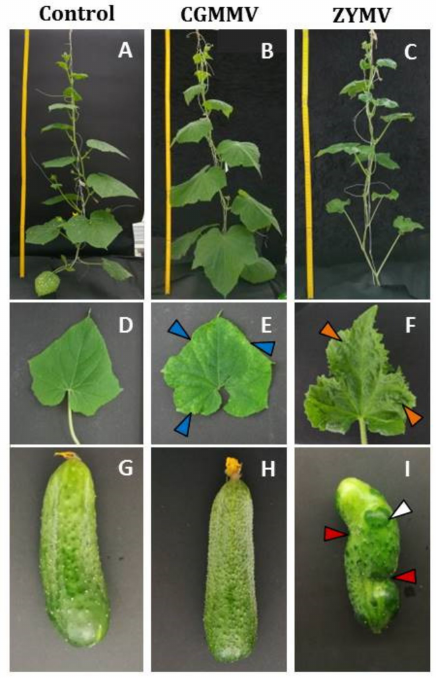
Figure 2. Macroscopic effect of CGMMV and ZYMV in C . sativus . Control plants show a healthy appear- ance ( A , D , G ). Plant growth ( B ) and fruit appearance ( H ) of CGMMV-infected plants were comparable to control. On leaves ( E ) soft mottling (blue arrow heads) could be observed. ZYMV-infected plants showed small leaves ( C ), blistering (orange arrow heads) and deformation on leaves ( F ) as well as malformation (red arrow heads), proliferation (white arrow head) and discoloration of fruits ( I